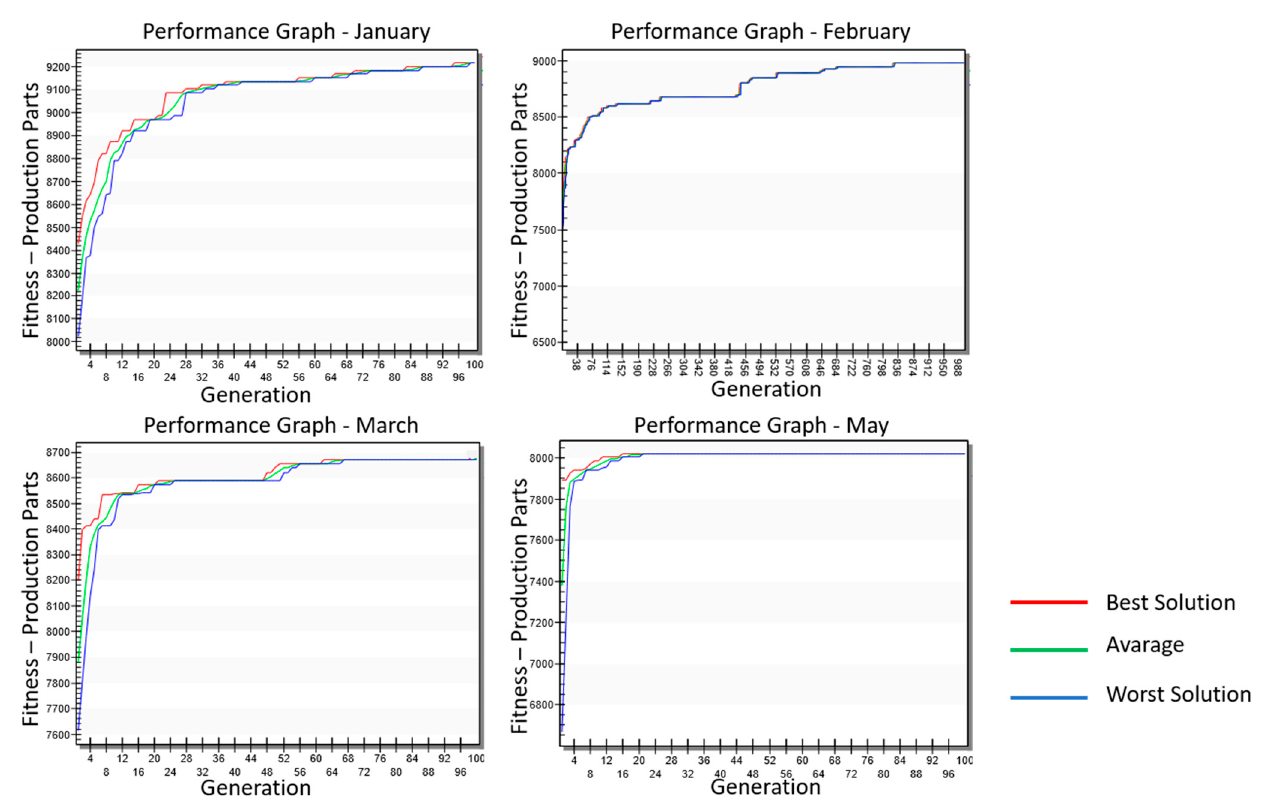
Figure 6. Evolution of the results in the months analyzed.